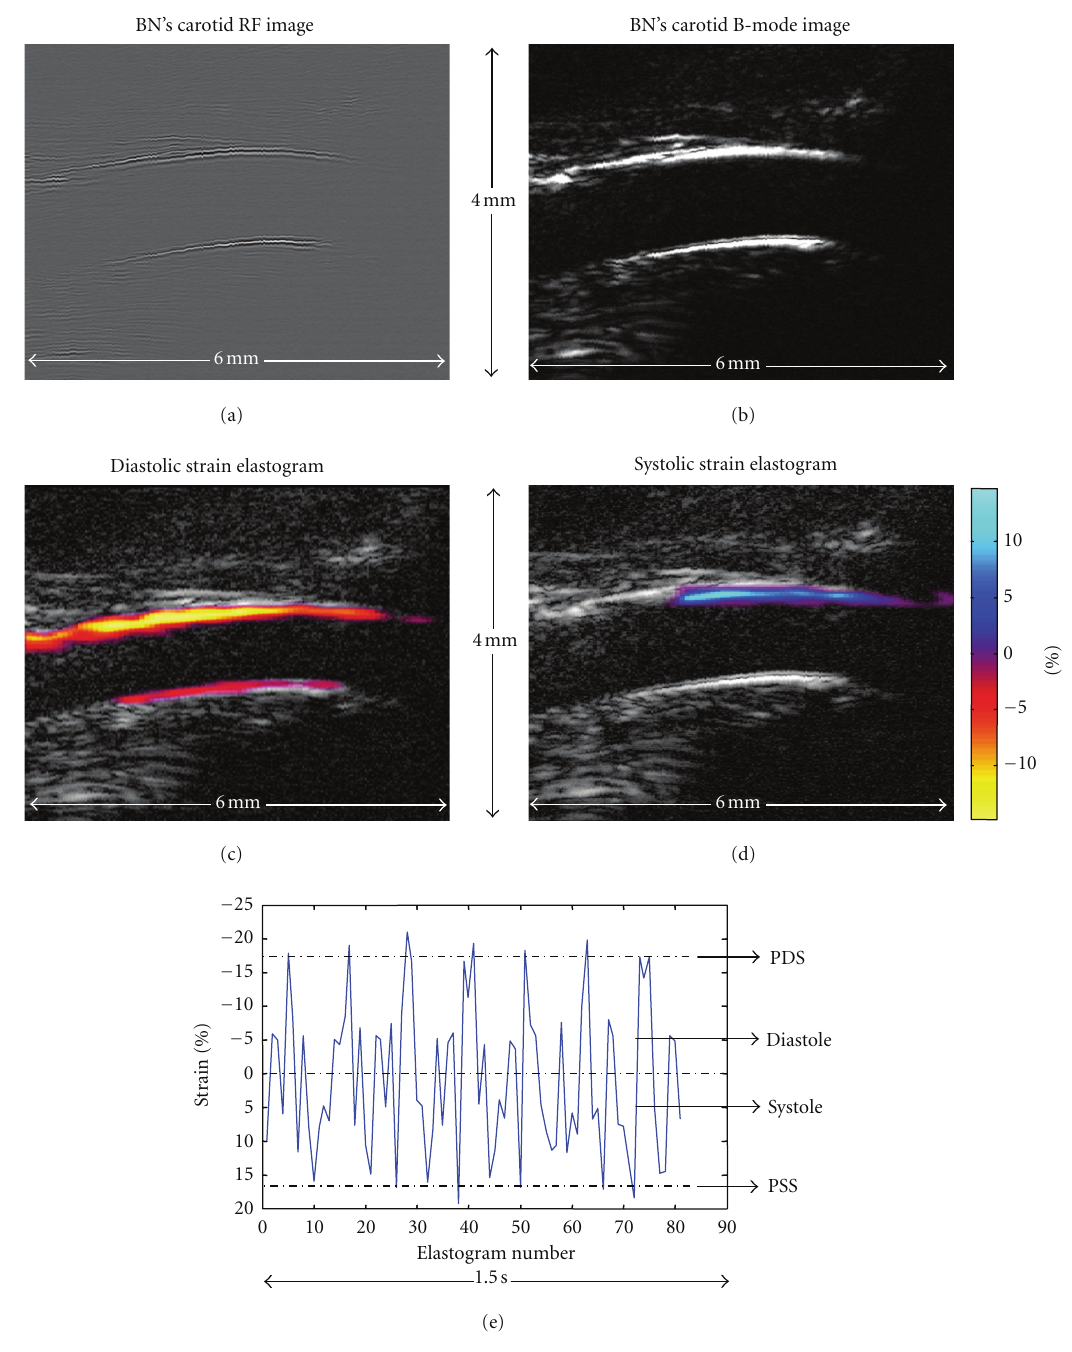
Figure 1: (a) BN’s carotid RF image, (b) BN’s carotid B-mode image, (c) diastolic strain elastogram that superimposes the B-mode image, (d) systolic strain elastogram that superimposes the B-mode image, (e) MAS curve showing the PDS and PSS parameters that were used as relative measures of sti ff